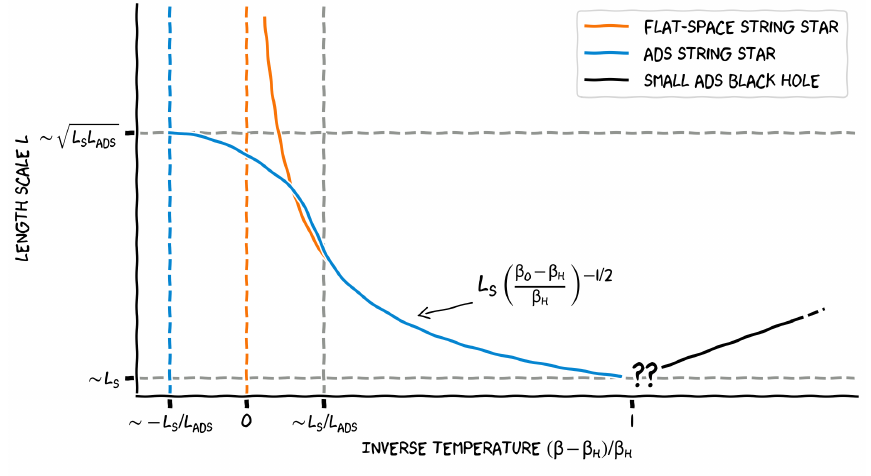
Figure 2 . Schematic picture of the string star solution’s length scale as a function of the inverse temperature ( β − β ) /β for 3 ≤ d ≤ 5 . In orange we see the flat space solution of [7]. In blue H H the AdS solution. The two coincide for low temperatures. They also coincide with the small (AdS) black hole (drawn in black) at the correspondence point. The blue vertical line is the AdS Hagedorn temperature β c